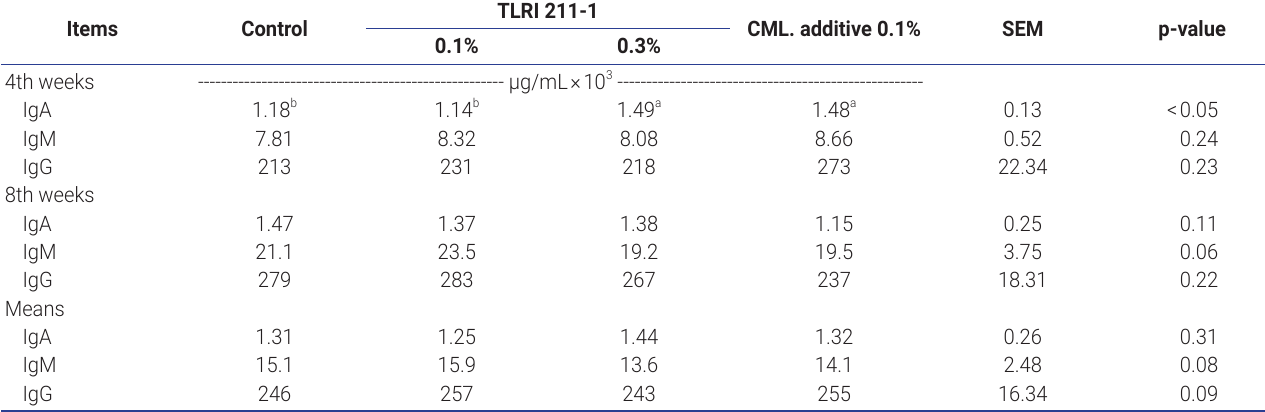
Table 7. Effects of dietary supplementation of Bacillus subtillis and B. amyloliquefaciens on blood immunoglobulin of Leghorn laying hens